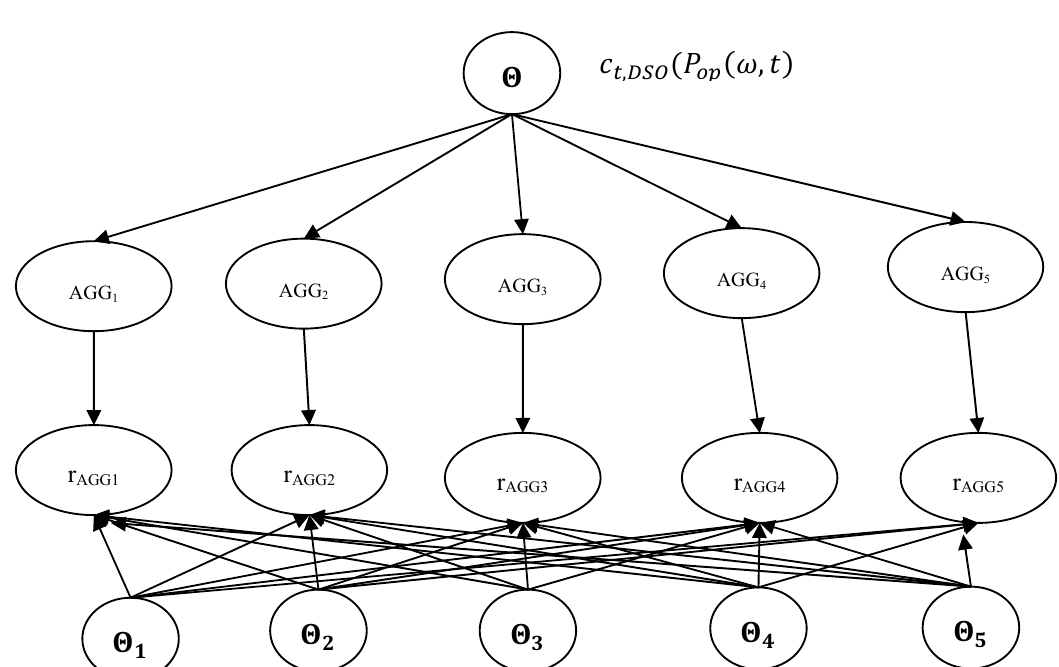
Figure 6. Bayesian network showing DSO and aggregator parameters (AGG means ‘aggregator’).